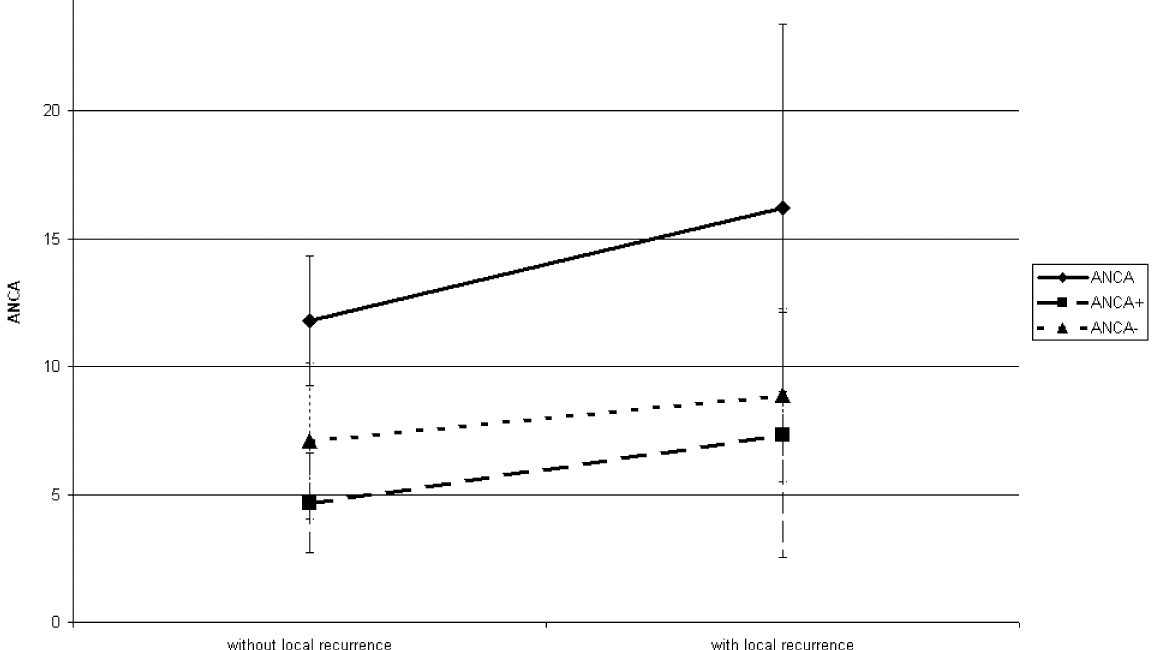
Fig. 2. Averaged number of copy alterations (ANCA) for the comparison of primary tumors with and without local recurrences. The vertical lines represent the standard